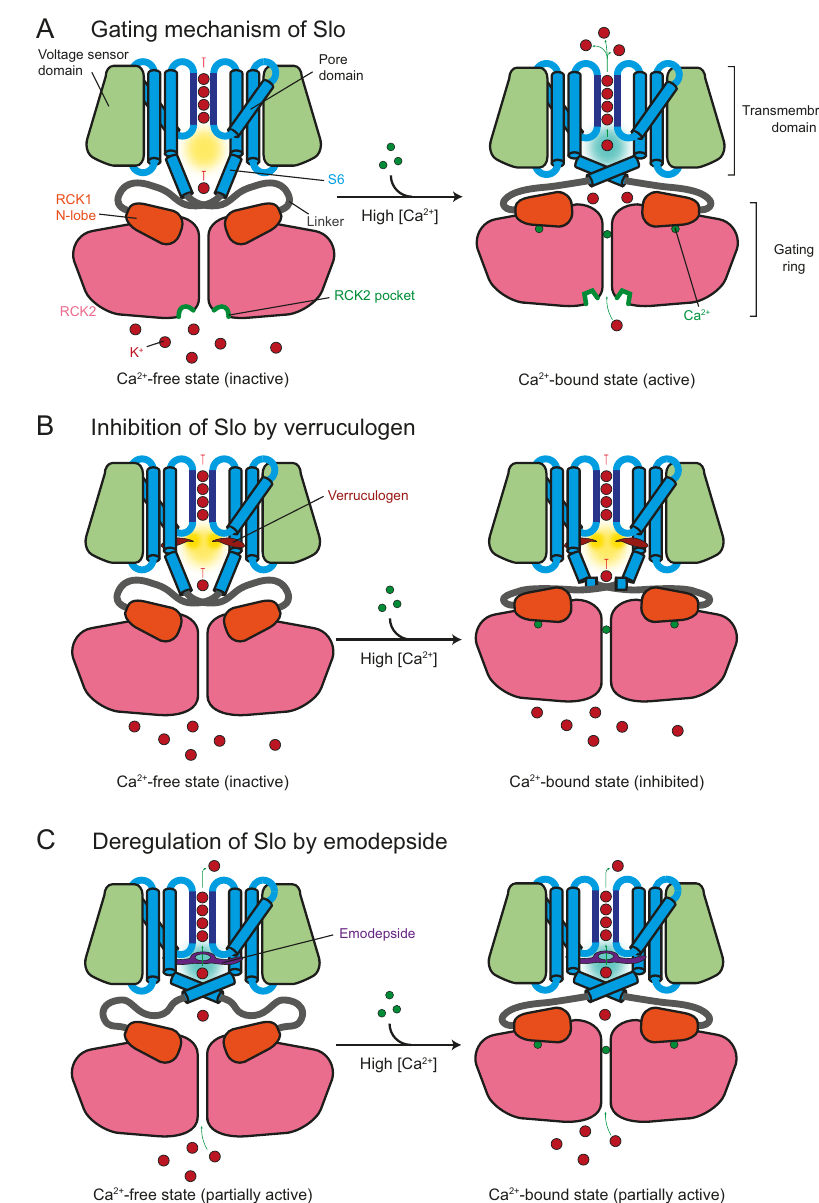
Fig. 6 Verruculogen and emodepside modulate the activity of Slo. A Schematic representation of Slo in the Ca 2 + -free inactive (left) and Ca 2 + -bound active (right) conformations. Upon Ca 2 + binding to the gating ring, the RCK1 N-lobes move outward, leading to a rearrangement of helix S6 in the TMD. This rearrangement widens the entry to the cavity and buries hydrophobic patches along its walls. Thus, K + ions can access the selectivity fi lter and be translocated to the extracellular space. The predicted RCK2 pocket (green) also changes its conformation upon Ca 2 + -binding and offers the possibility of locking either conformation by novel small molecules. B Verruculogen (red) binds to the cavity pocket which is only exposed in the Ca 2 + -free state and prevents helix S6 from adopting the active conformation upon Ca 2 + binding. This, together with the hydrophobic environment in the cavity which is enhanced by verruculogen precludes K + ions from reaching the selectivity fi lter and being translocated. C Emodepside (purple) binds to the intracellular entryway in the cavity and restricts access to the selectivity fi lter by suboptimal K + coordination. As emodepside likely stabilizes the active conformation of helix S6 also in the Ca 2 + -free state, K + translocation is effectively uncoupled from regulation by Ca 2 + concentration and the transmembrane Ligand-bound structures will facilitate the design of novel compound is positioned in a way that it could coordinate and drugs acting on Slo . In conclusion, we identi fi ed a novel stabilize a non-hydrated K + ion in the S6 position inside the potential insect-speci fi c drug-binding pocket, termed RCK2 central cavity where, in the absence of emodepside, hydrated K + are focused and positioned to be stripped off their hydration shell pocket, and provide structural and functional data that explain (Fig. 6C). Since our Cryo-EM data were acquired in the presence how Slo activity can be ef fi ciently modulated by small molecules of Ca 2 + , it is not clear how emodepside uncouples ion translo- (Fig. 6). Verruculogen acts as a classical inhibitor that prevents K + ions from reaching the selectivity fi lter (Fig. 6B). In contrast, cation from activation by intracellular Ca 2 + concentrations and voltage sensing. While it is tempting to speculate that emodepside the mechanism of action of the emodepside is more complex. The